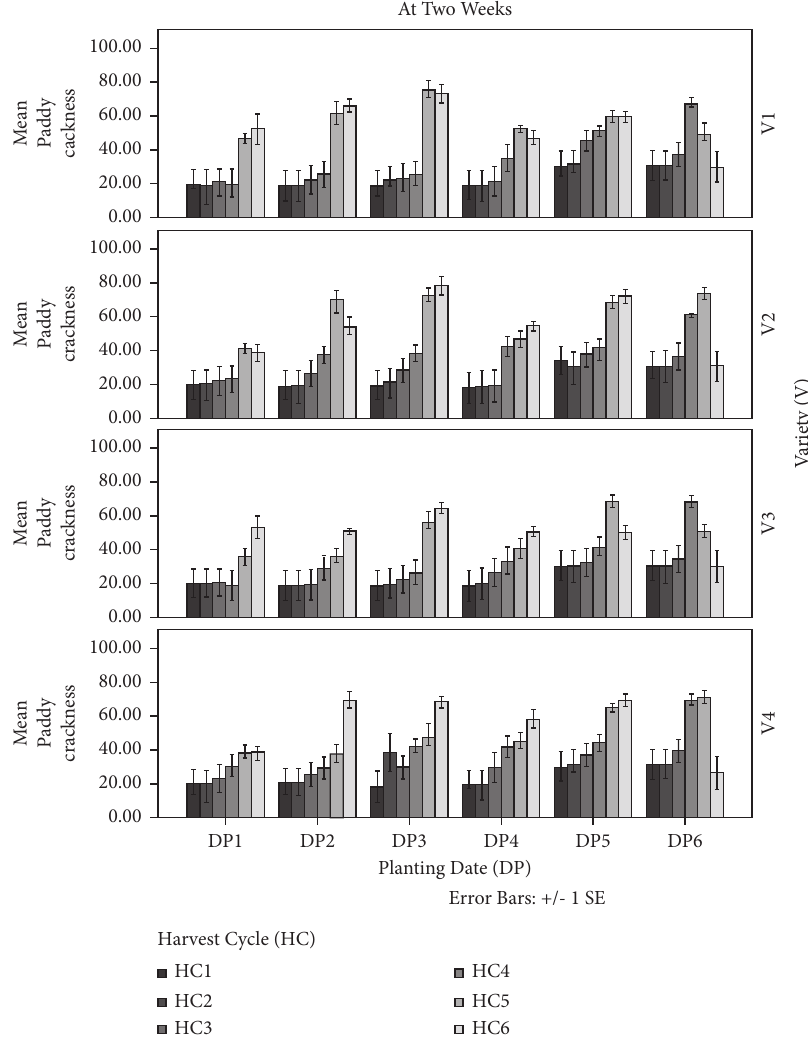
Figure 4: Effect of planting date, variety, and harvest cycle on paddy crackness at two weeks of storage in the Northern Savanna Agroecological Zone of Ghana. Bars represent the SEM. DP1 � first planting, DP2 � second planting, DP3 � third planting, DP4 � fourth planting, DP5 � fifth planting, DP6 � sixth planting, V1 � Agra, V2 � Gbewaa, V3 � Exbaika, V4 � Perfume Irrigated, HC1 � first harvest, HC2 � second harvest, HC3 � third harvest, HC4 � fourth harvest, HC5 � fifth harvest, and HC6 � sixth